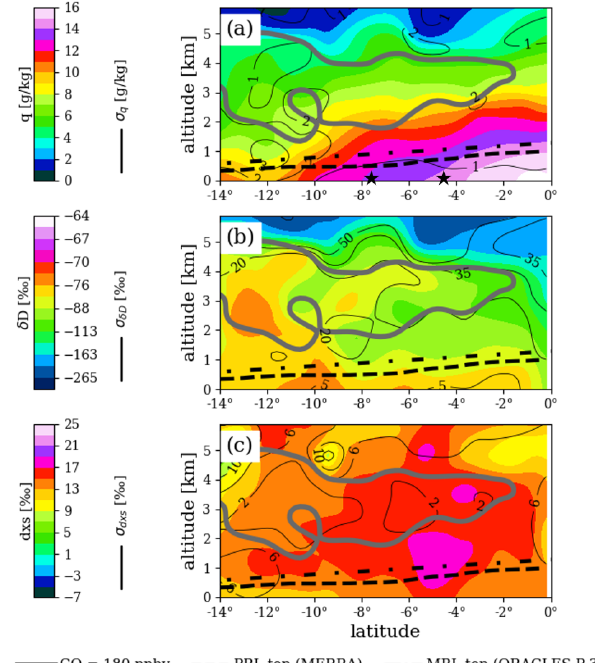
Figure 8. Same as Fig. 6 but for the ORACLES 2018 data. Black stars at the bottom of panel (a) are placed at the latitudes of the two vertical profiles in Fig. 11.